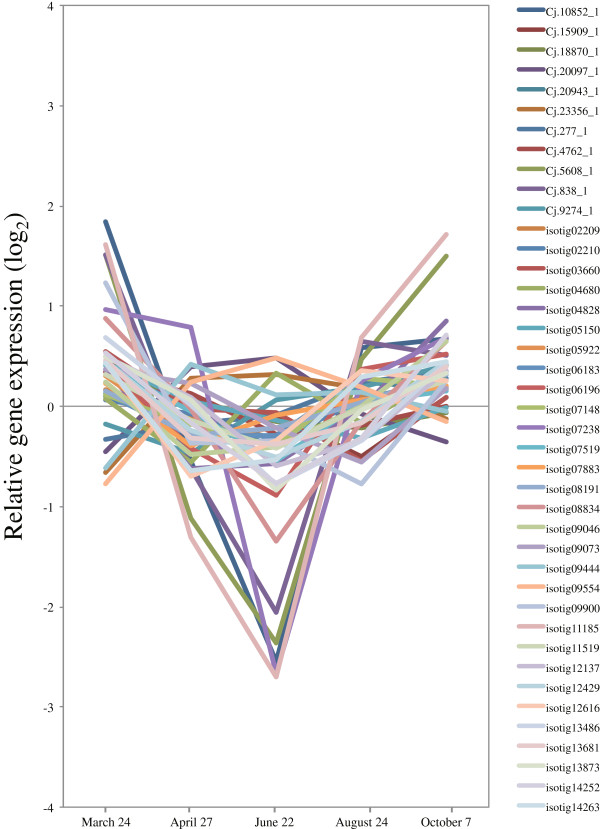
Expression of starch-breakdown related genes in cambial region during xylem formation. The individual targets are summarized in Additional file 3. All expression data are presented on a log2 scale.